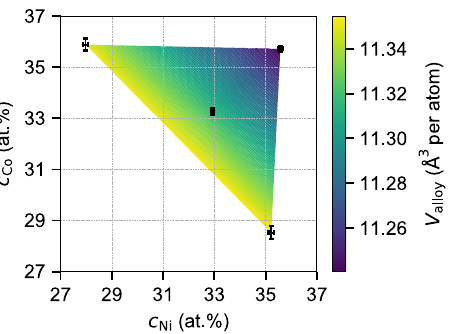
Fig. 2 Measured composition and atomic volume of Ni – Co – Cr samples at four compositions around the equi-composition alloy. The actual compositions with the uncertainties are shown by the black symbols. The color map indicates the alloy atomic volume computed by a linear interpolation of the measured volumes.